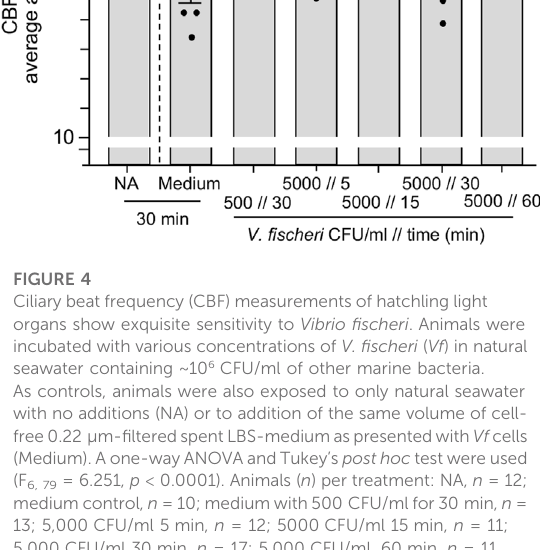
surface just above the pores (Figure 1B). To assess the nature of these ciliated fl ows, we fi rst computed the Reynolds number Re, de fi ned as Re = ρ UL/ η , where ρ and η are the water density and viscosity, L is the length scale of the ciliated appendages, and U is the speed of the cilia-generated currents. For ρ = 1 g cm − 3 and η = 8.9 · 10 – 3 g cm − 1 · s − 1 at 25 ° C and, considering L = 200 μ m